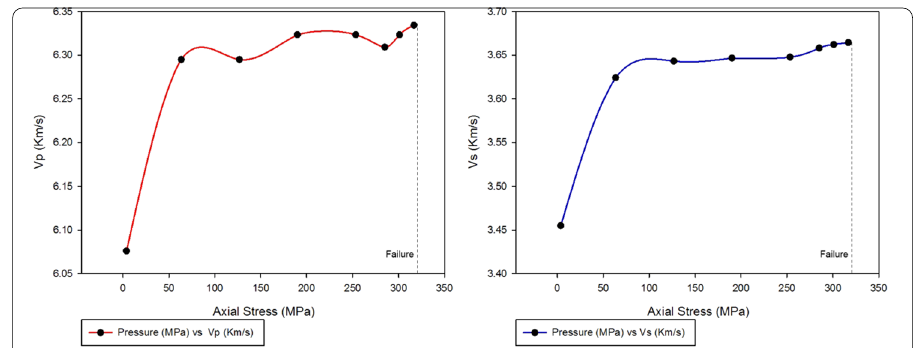
Fig. 9 Seismic wave velocities ( V p and V s ) measured during triaxial compressive test